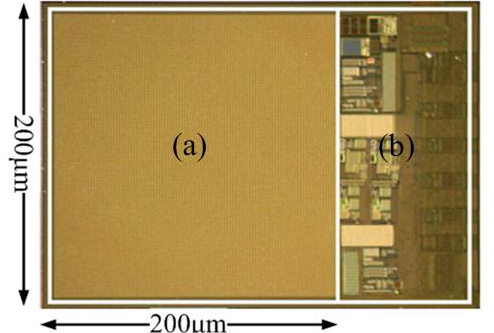
Figure 5. Microphotograph of the fabricated chip: ( a ) capacitive humidity sensor element; ( b ) interface